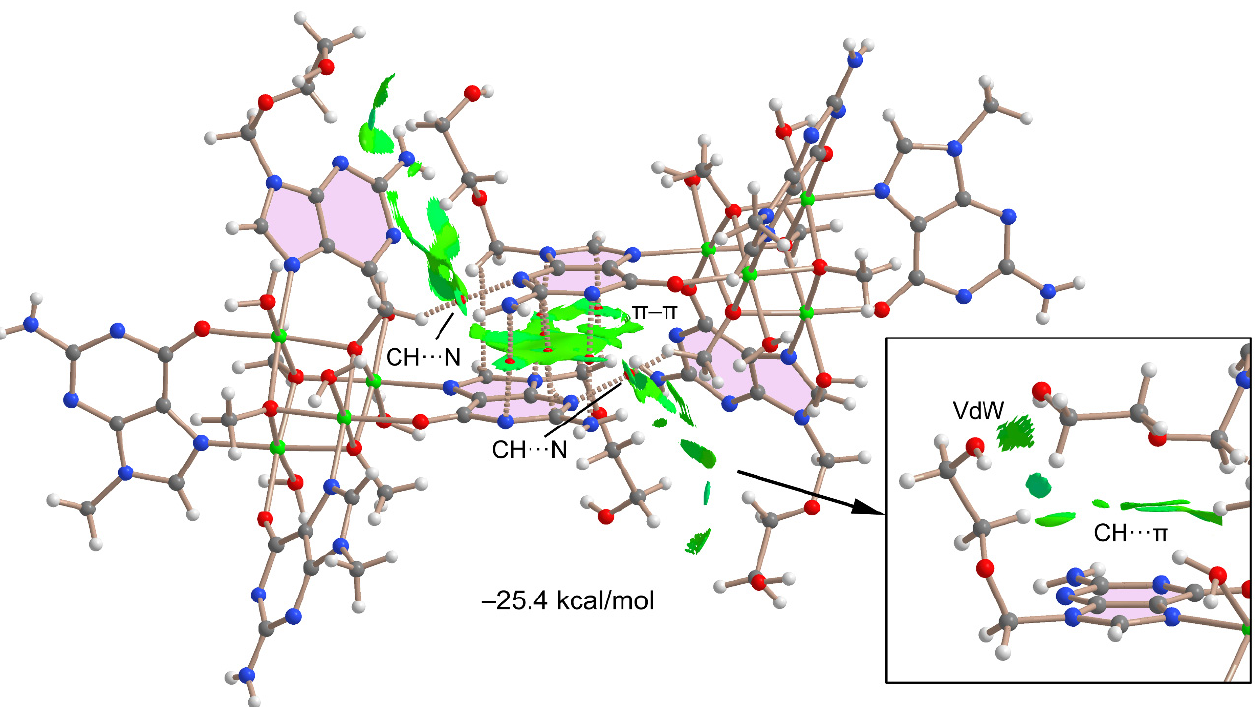
Figure 6. QTAIM analysis (bond CPs in red and bond paths as dashed bonds) and NCI plot analysis [(sign λ 2 ) × ρ scale: ± 0.03, ρ cut-off 0.04 a.u.] of the π -stacked assembly of compound 1 . Only intermolecular interactions are represented.